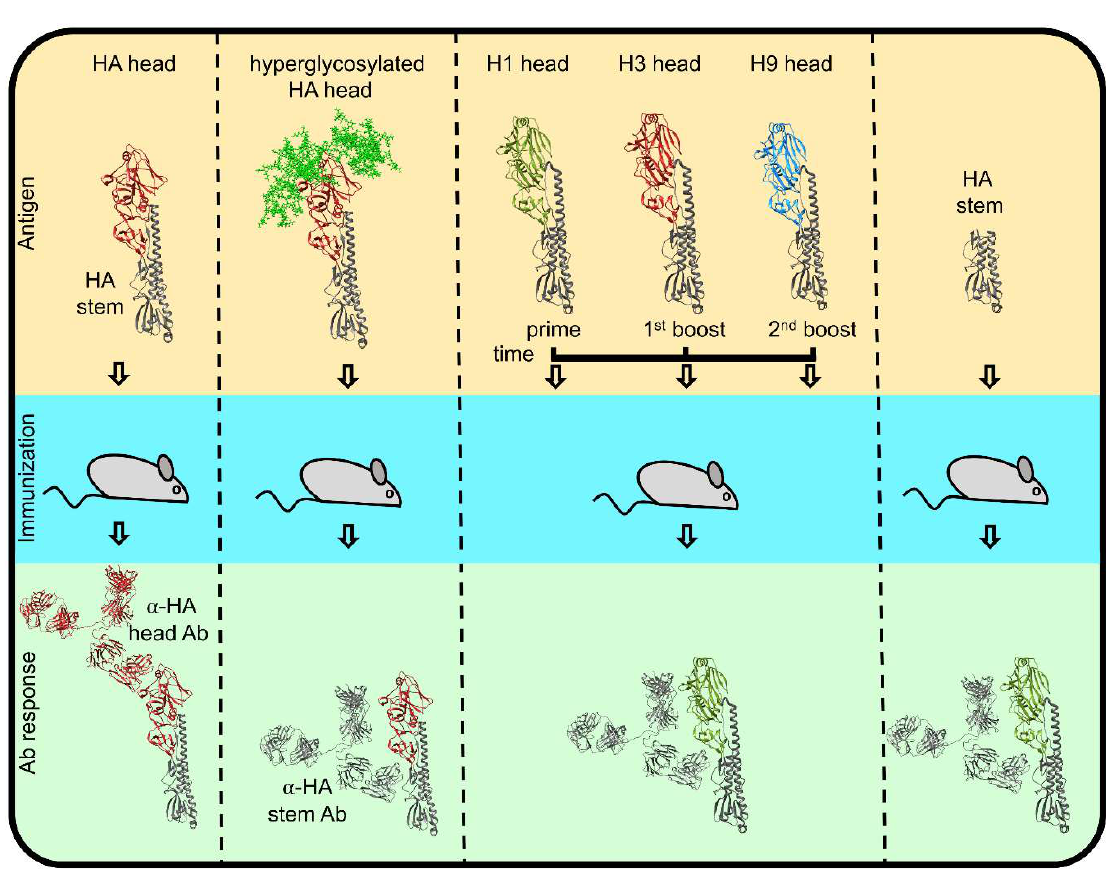
Figure 5. The mechanisms of humoral response modulation towards HA stem domain. If regular HA (top left) is used as an immunogen, the dominant antibody response is directed towards the head domain (dark red). Immunization with hyperglycosylated HA head (complex glycans colored bright green) or sequential immunization with dissimilar head (olive green, dark red, bright blue), identical stem (dim gray) constructs (top middle), or physically separated stem (top right) all result in anti-stem dominated Ab responses.